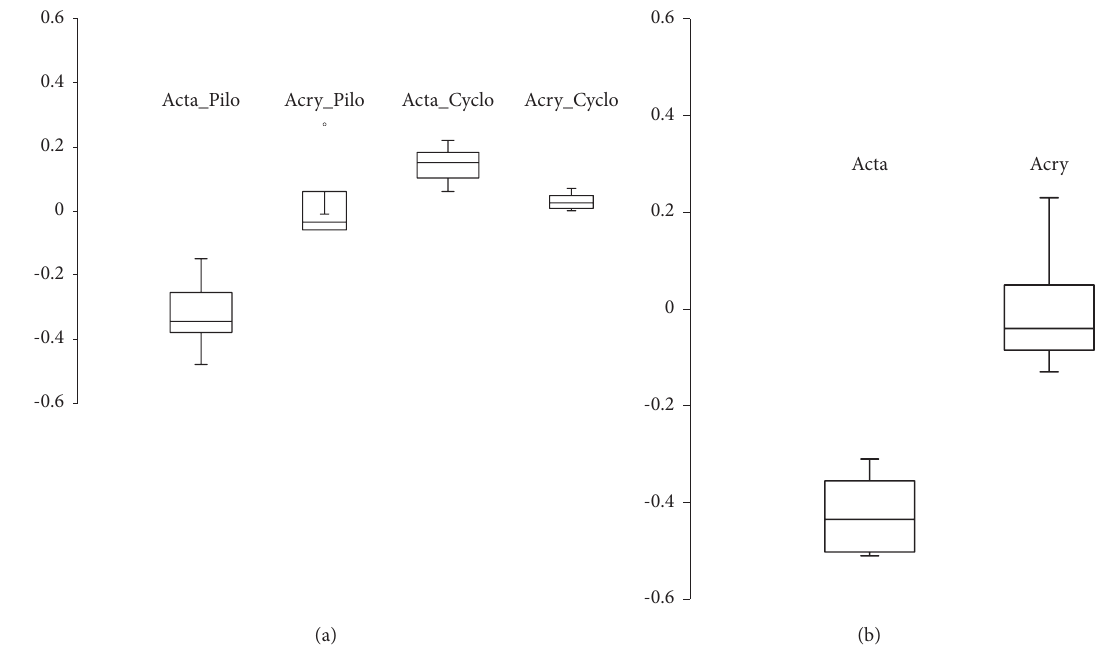
Figure 2: (a) Pilocarpine and cyclopentolate shift for the two investigated IOLs. (b) Calculated difference between pilocarpine and cyclopentolate shift for both investigated